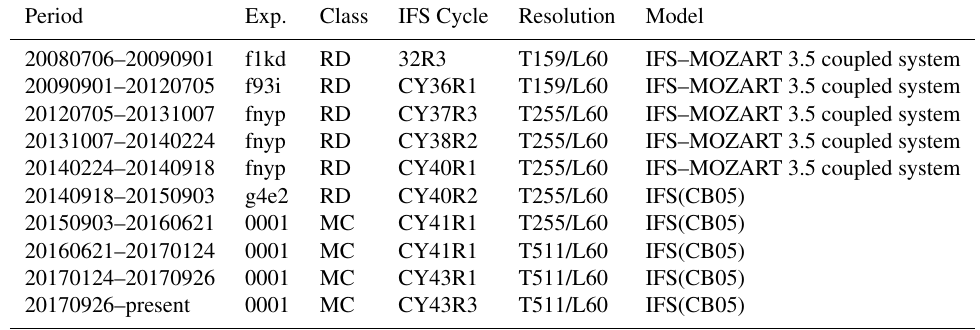
Table A1. List of GEMS–MACC–CAMS model versions showing the time evolution of the real-time CAMS system since July 2008.